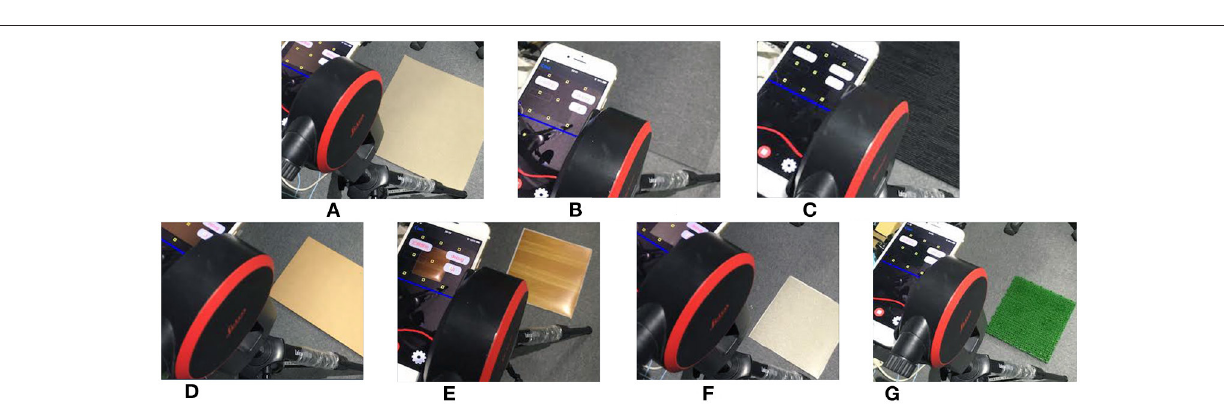
mean errors and standard deviations including all measured distances ( d 0 = 0.0, 0.5, 1.0, 1.5, 2.0, 3.0, and 3.5 m) are shown in Figure 5 . Note that the result at the ISO 22 and SS 1/1,000 setting was not available because missing values were observed in the measurement. When the ISO value was set too low, the distance